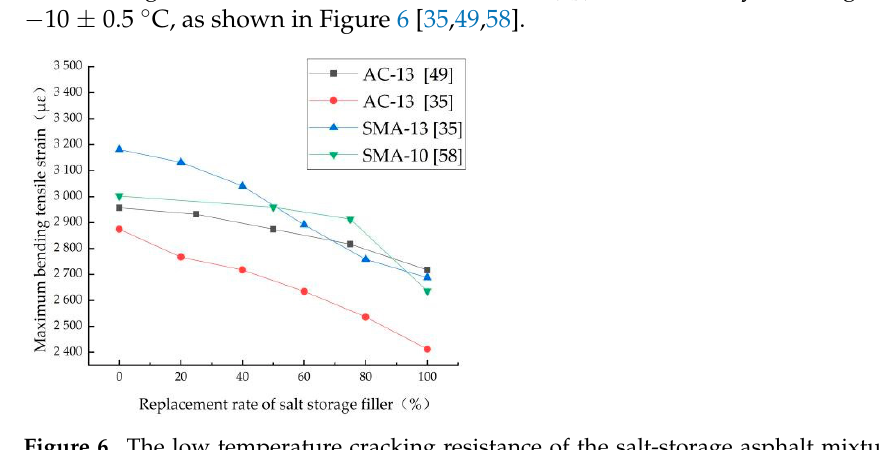
Figure 6. The low temperature cracking resistance of the salt-storage asphalt mixture. (Li, et al. 2012 [35], Stroup 2008 [49], Wang 2017 [32])